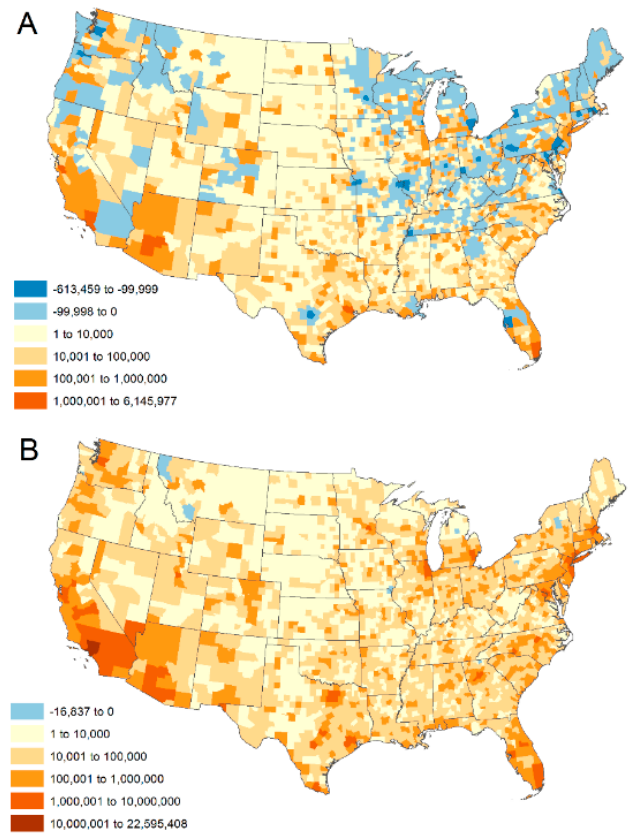
Figure 3. Population change by county between 2010 and 2090 under SSP2 ( A ) and SSP5 ( B ).